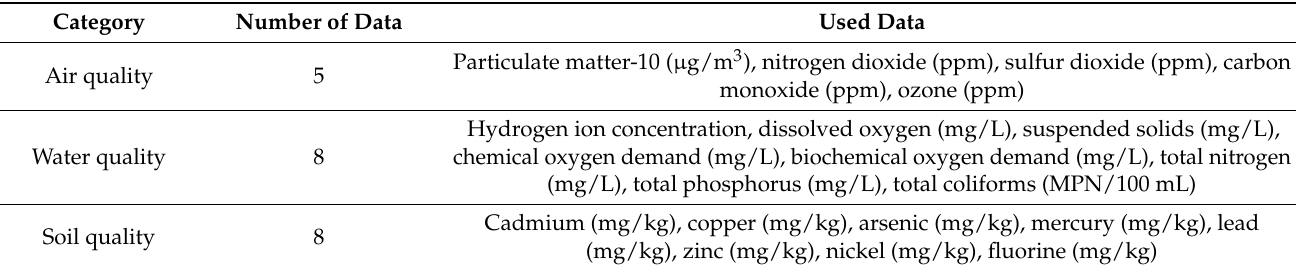
Table 2. EIA Big Data selected to produce the new index.